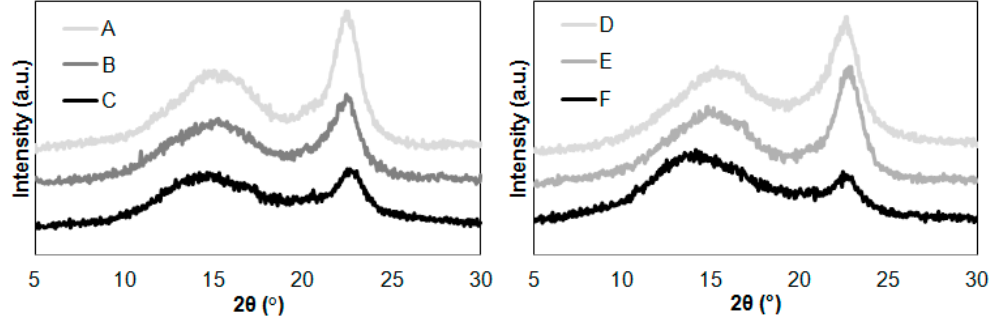
Figure 2. XRD patterns of cellulose after hydrolysis reaction with ionic liquids: ( A ) Avicel, ( B ) Avicel